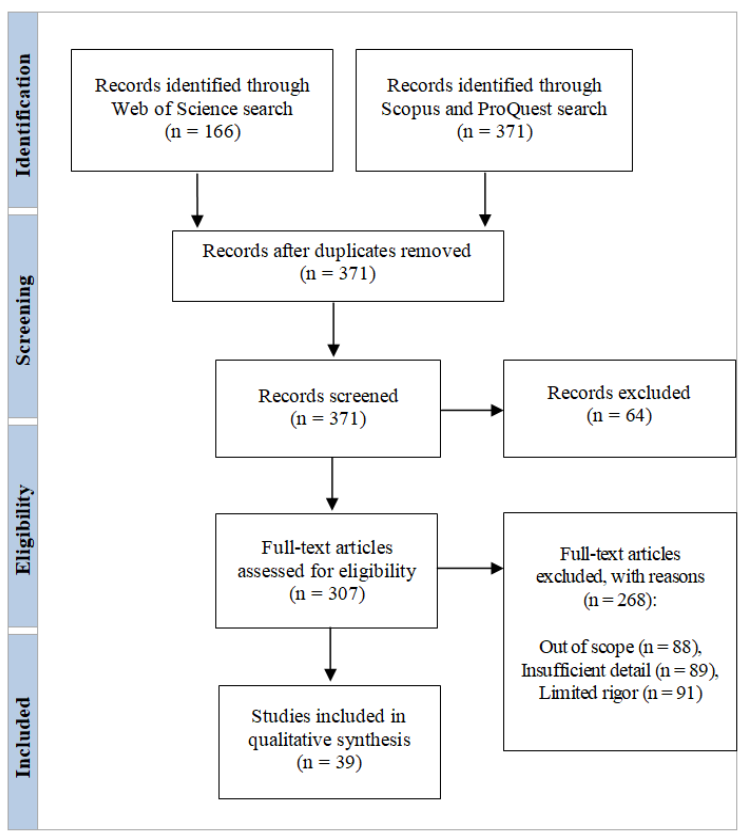
Figure 5. PRISMA flow diagram describing the search results and screening.